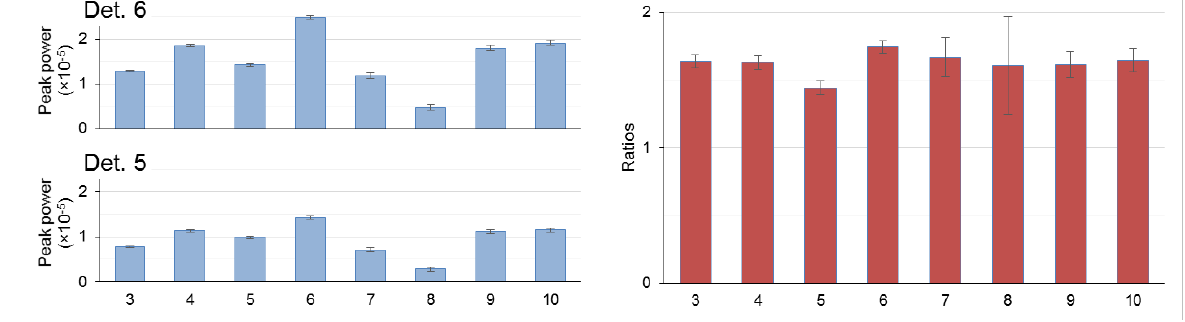
Figure 3. In blue, PSD peak power estimates of selected detectors 3 to 10 for an experiment (±1.5 mm /1 Hz) with respect to detectors 6 (top) and 5 (bottom), and comparatively with the ratios (red, right). Table I. Calculated ratios 𝑹 for the selected experiment (±1.5 mm /1 Hz) for all used detectors . Last 𝒊𝒋𝟓 lines indicate: weighted average ratios 𝑅 , their deviation from 𝑅 , and reduced uncertainties, and 𝑖5 55 〉 reconstructed by normalization to detector 6 (i.e. 𝑃 ⁄ ∙ 𝑅 absolute peak power 〈𝑃 𝑅 ). 𝑖−5 5−6 65 𝑖5 Ratios 𝑅 Detector 𝑗